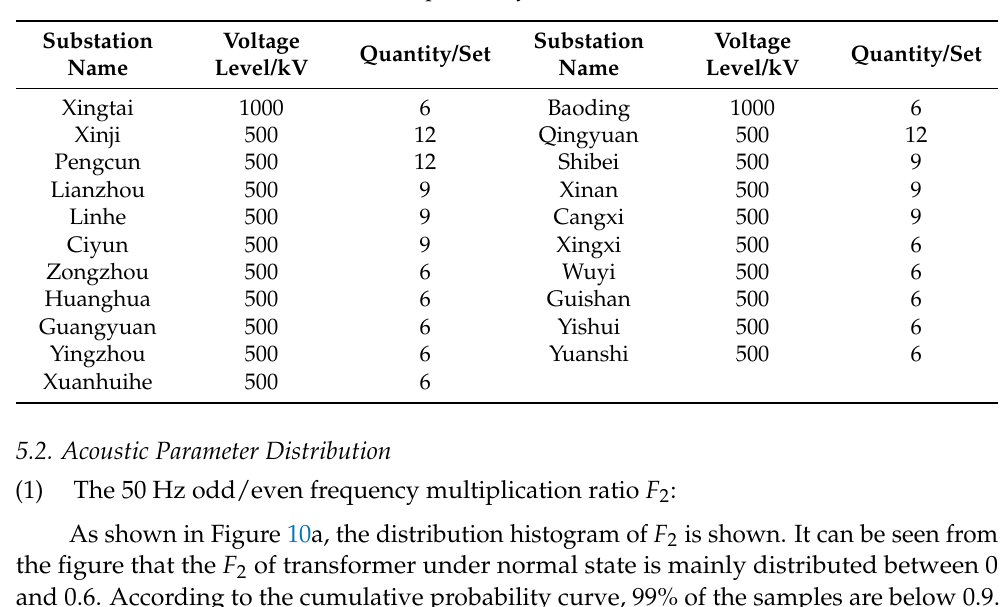
Figure 10. Distribution histogram and cumulative probability curve of transformer acoustic typical eigenvalues. ( a ) Ratio between odd and even harmonics F 2 . ( b ) Ratio of fundamental frequency F 3 . ( c ) Total harmonic distortion F 4 .